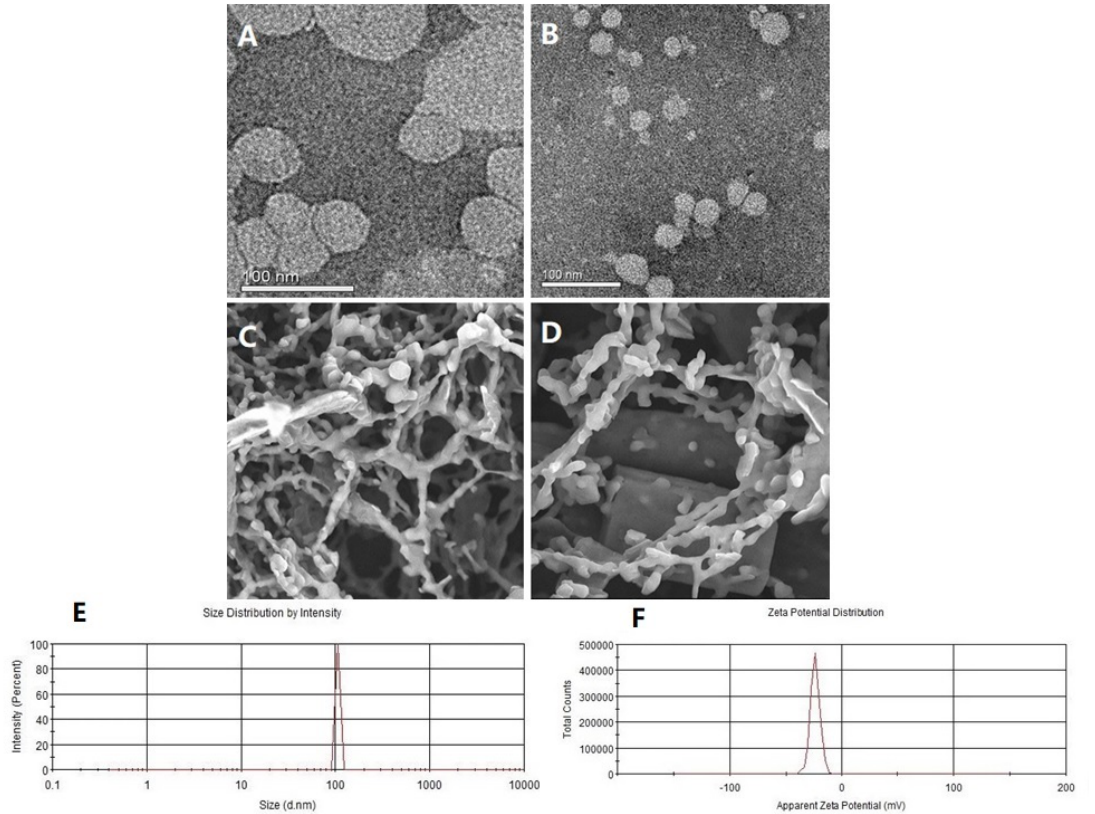
Figure 1. Characterization of RSV-SLN and SLN. TEM images of ( A ) SLN and ( B ) RSV-SLN after they were stained with one drop of 2% phosphotungstic acid. SEM images of ( C ) SLN and ( D ) RSV-SLN. ( E , F ) The size distribution and zeta potential for RSV-SLN. RSV: Resveratrol; SLN: solid lipid nanoparticles.